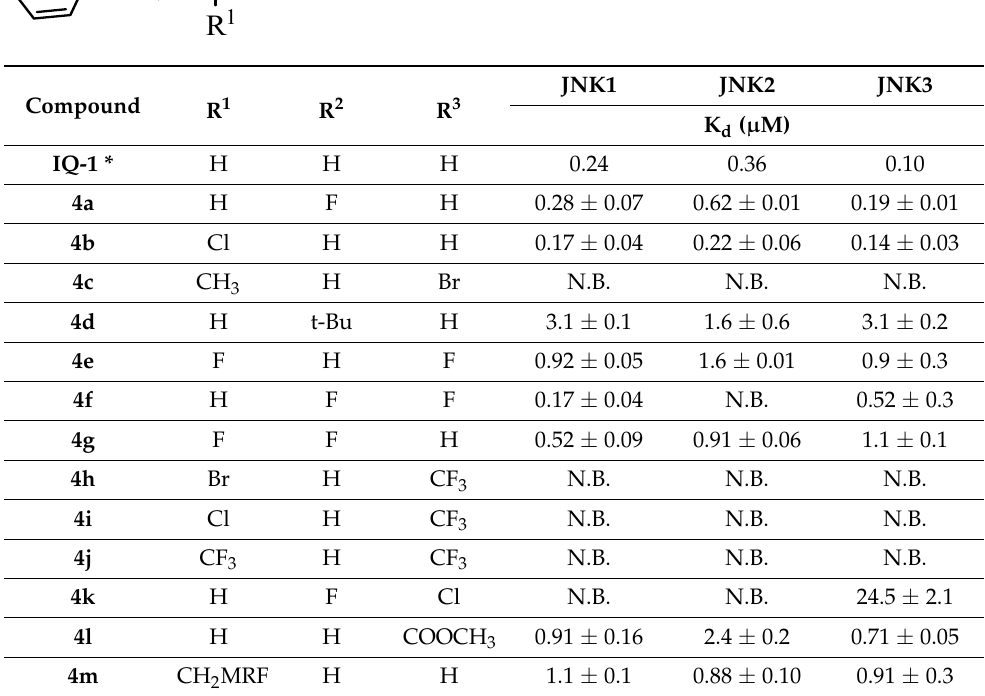
Table 3. Chemical structures of synthesized oxime derivatives and JNK binding affinity.